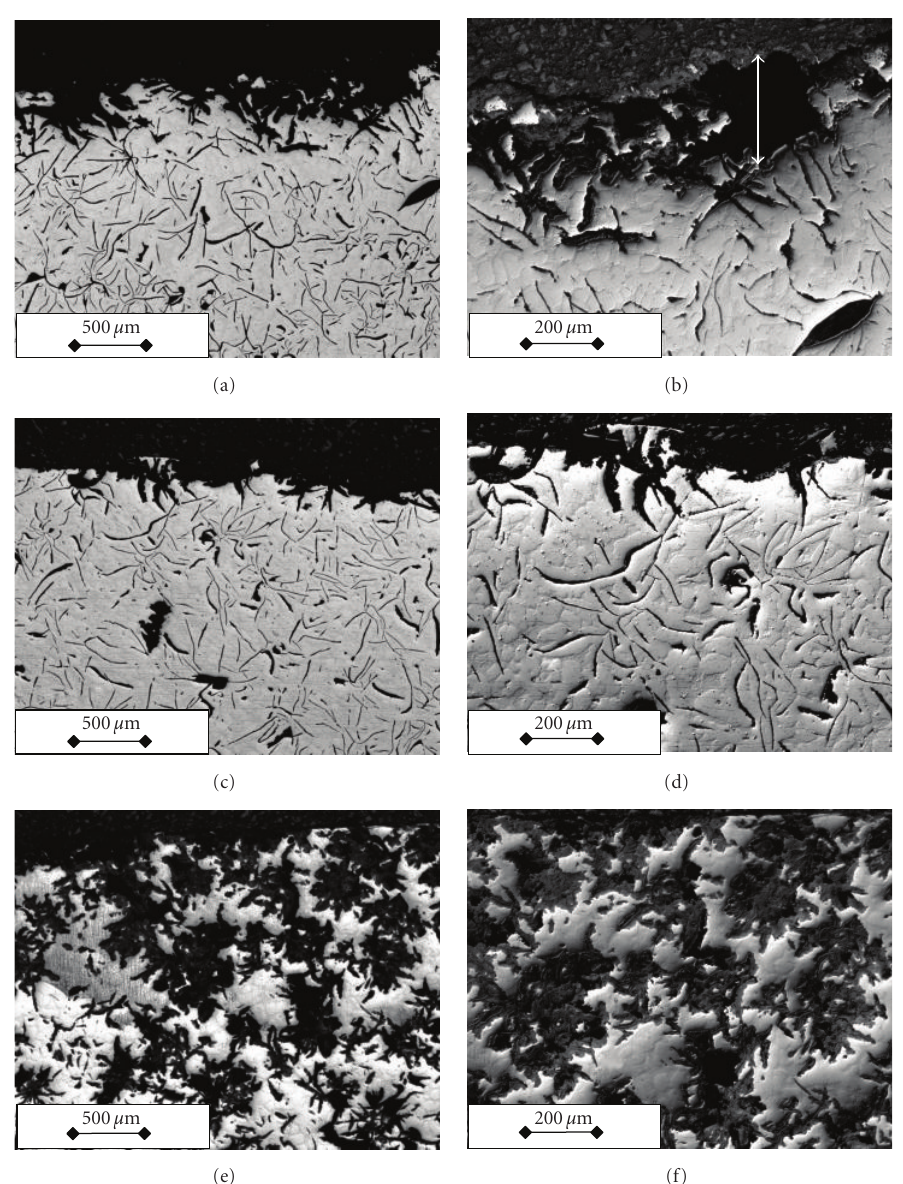
Figure 8: Photomicrophotographs of representative